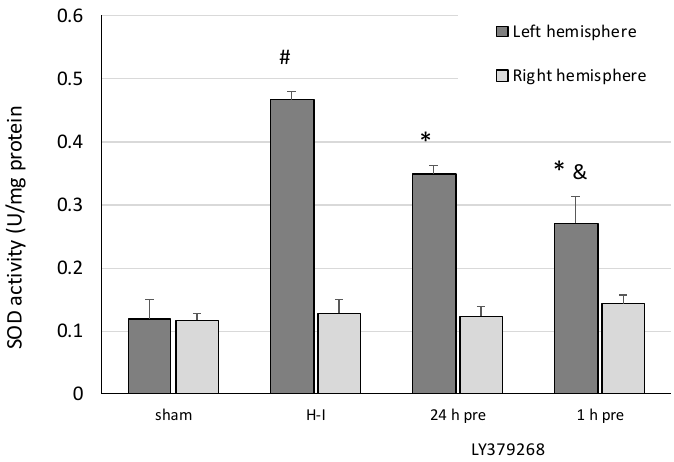
Figure 3. The effect of LY379268 pretreatment on changes in superoxide dismutase (SOD) activity evoked by H-I. The results are presented as the mean ± SD, n = 3–5; #—significantly different from the sham-operated group, p < 0.005; *—different from the H-I group, p < 0.005; &—different from the group injected 24 h before H-I, p < 0.01.